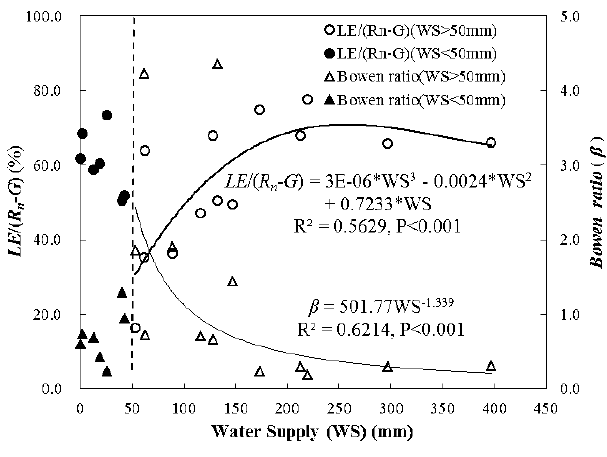
Figure 8. The response of Bowen ratio and LE /(R n − G) to wa- ter supply (WS; including precipitation ( P ) and irrigation ( I ) dur- ing each individual period) of the different periods across the four growing